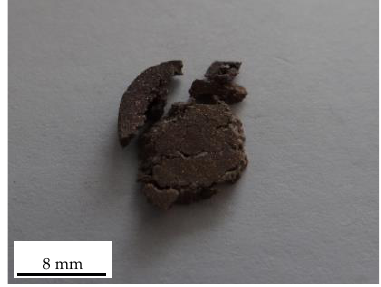
Figure 4. Failed PTFE/Cu sample.